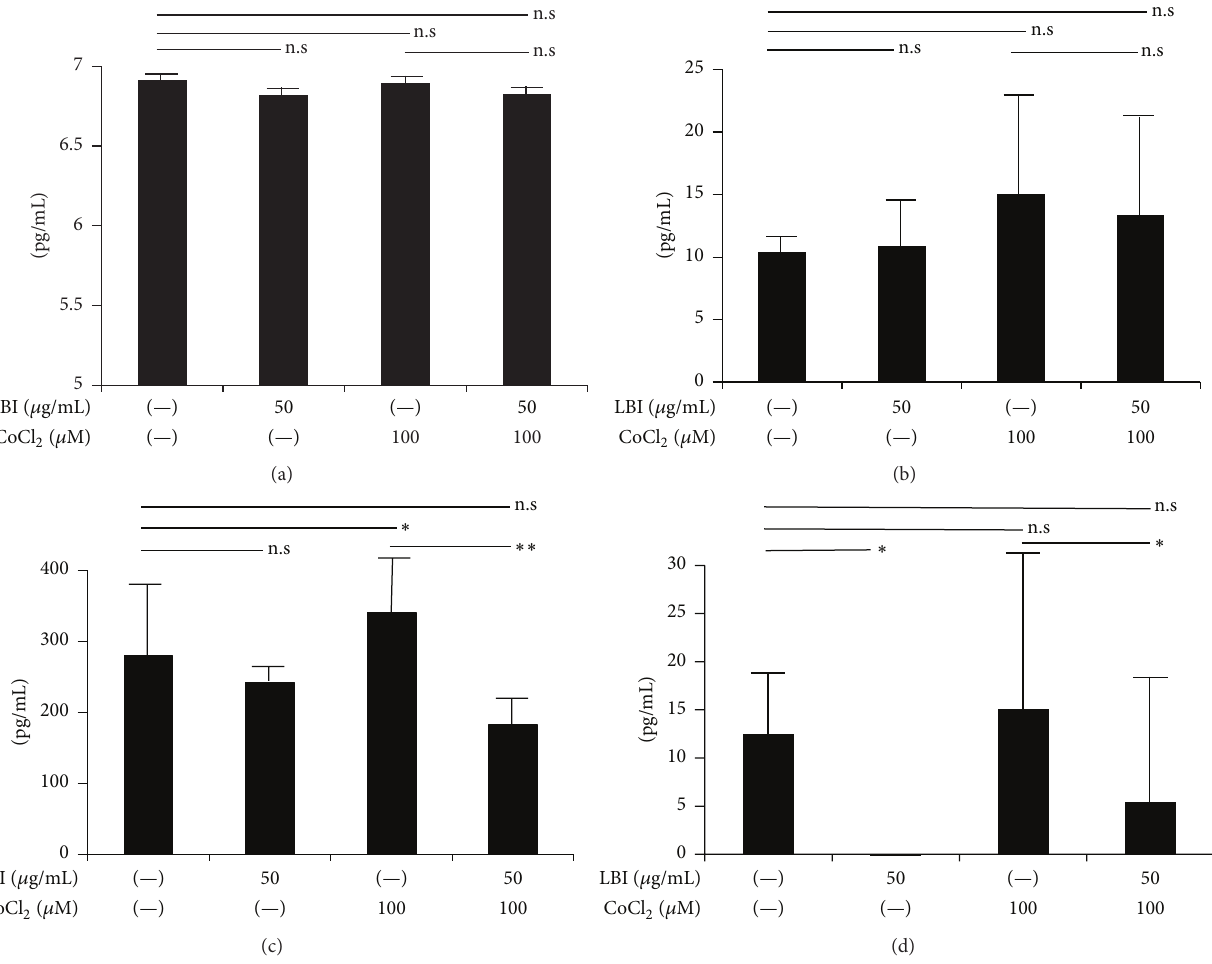
Figure 2: Hypoxia induces increases in MCP-1 and CCL-11 which is depressed by LBI pretreatment. ELISA was used to measure several cytokines in the conditioned culture media ( 𝑛 = 5 ). No significant changes are observed for IL-8 with the addition of CoCl 2 or LBI pretreatment (a). An increase in the IL-6 was observed after the addition of CoCl 2 while IL-6 decreases with the addition of CoCl 2 after LBI pretreatment (b). The significant increase in the MCP-1 observed after the addition of CoCl 2 . But it disappeared with LBI pretreatment (c). A similar tendency was also observed for CCL-11 (d). ∗ 𝑃 < 0.05 , ∗∗ 𝑃 < 0.01 , nonrepeated ANOVA. CCL-11, Chemokine (C-C